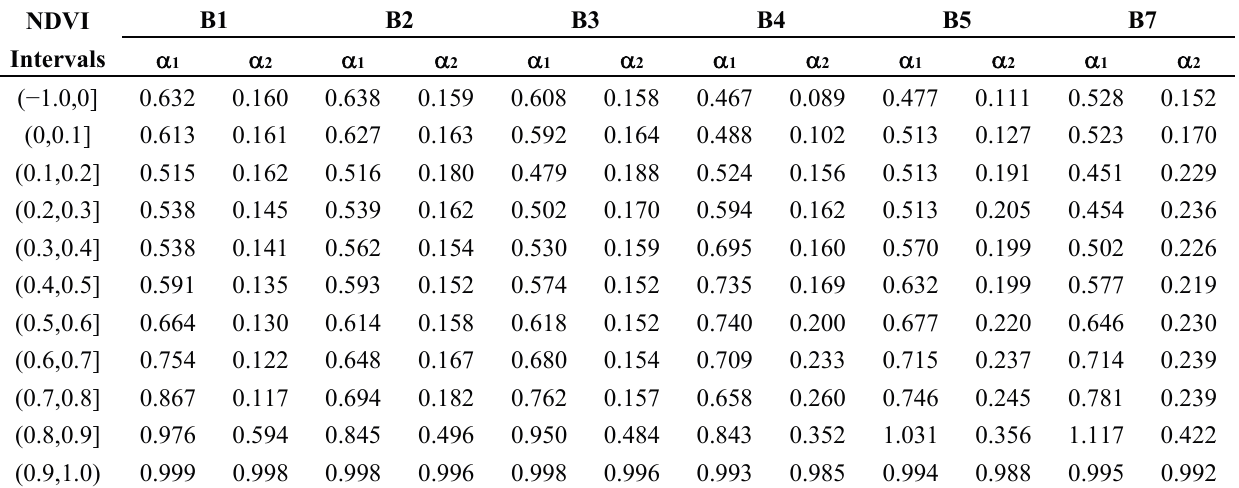
Table 1. BRDF shape function parameters for different NDVI intervals of each band for spring TM